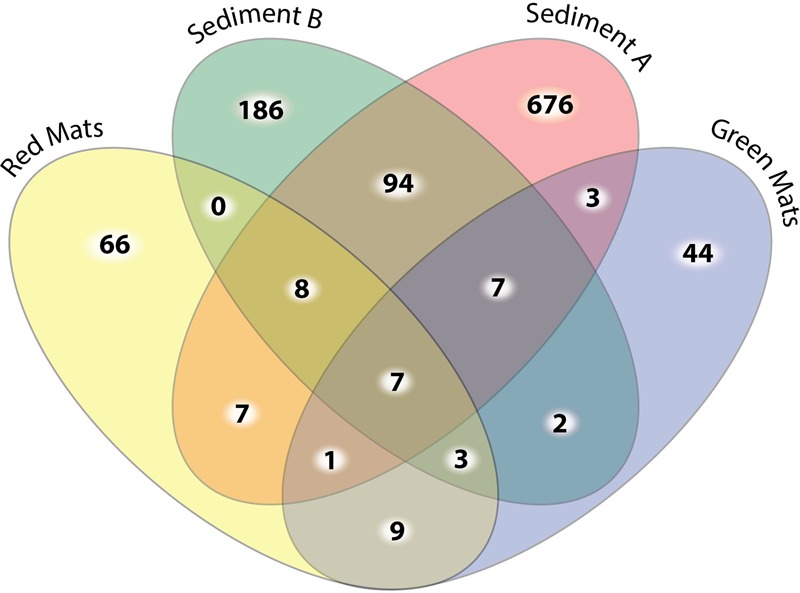
Four-way Venn diagram illustrating the number of shared unique OTUs at the 0.03 cut off level between samples. The sediment samples have the highest number of OTU diversity and the highest number of unique OTUs. Only 9 out of the 177 OTUs observed in the mat samples are observed in both mat communities.